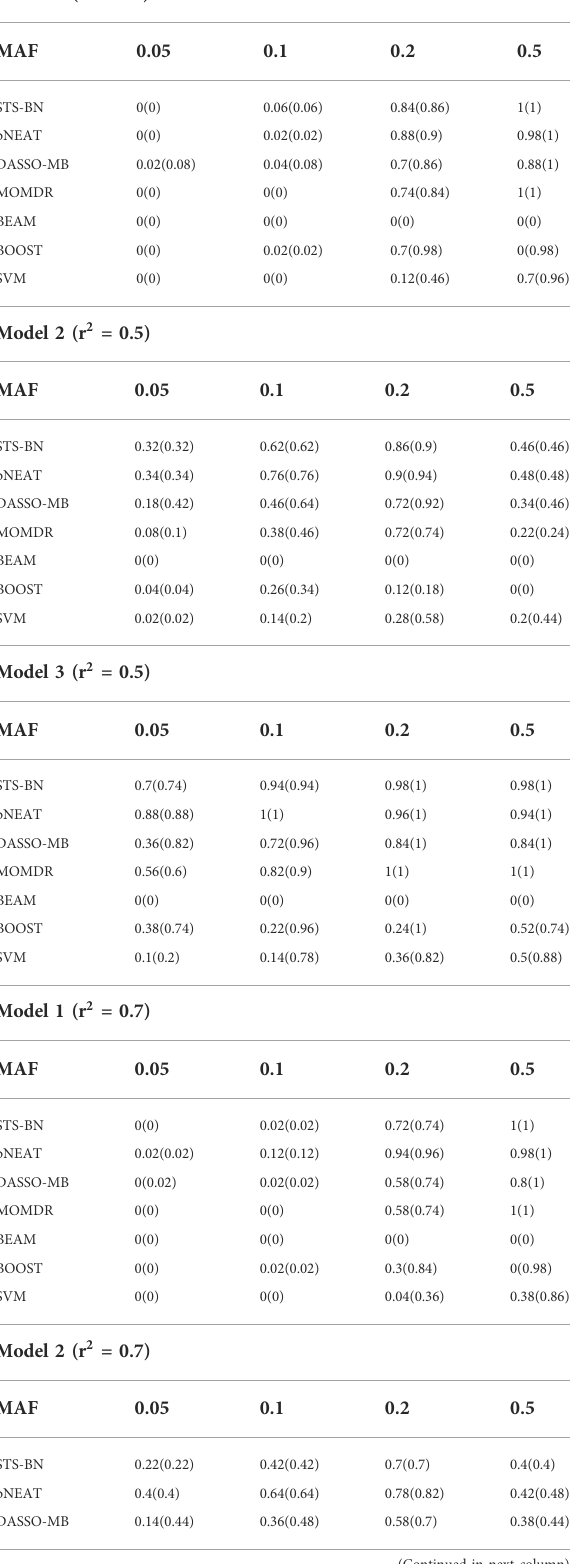
TABLE 4 Performance Comparison. Powers of simulations are given by this table. The percentage of the simulated datasets in which the correct markers are detected and at most two false positives are included is shown in the parentheses. Model 1 ( r 2 = 0.5)